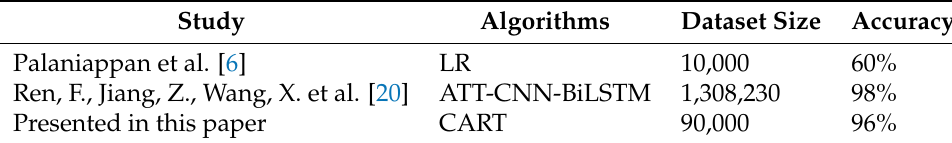
Table 6. Results comparison.